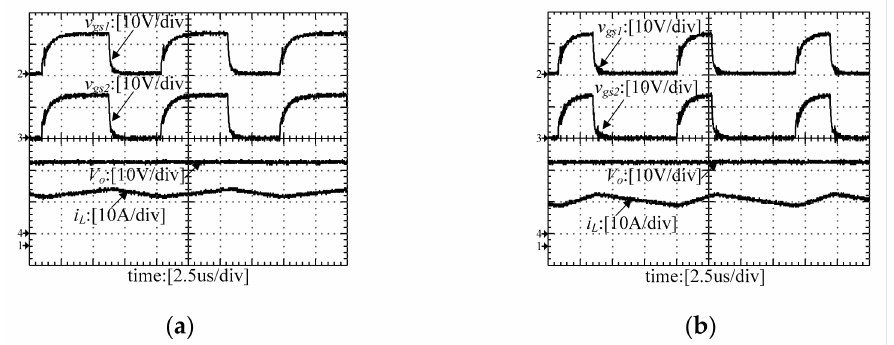
Figure 19. Steady-state experimental results. ( a ) Boost waveform. ( b ) Buck waveform.